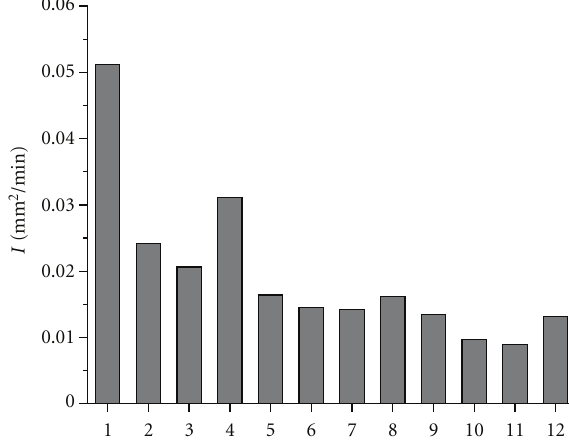
Figure 4: Wear intensity ( I ) of UHMWPE specimens: pure (1) and N + ion implanted with doses of 0.5 (2), 1 (3), 2 · 10 17 (4); nanocomposites UHMWPE +0.5wt.% HA in the initial state (5) and implanted one with doses 0.5 (6), 1 (7), 2 · 10 17 N + (8); micro- composites UHMWPE +20wt.% HA without surface treatment (9) and implanted ones with doses of 0.5 (10), 1 (11), 2 · 10 17 N + (12) at the steady-state wearing